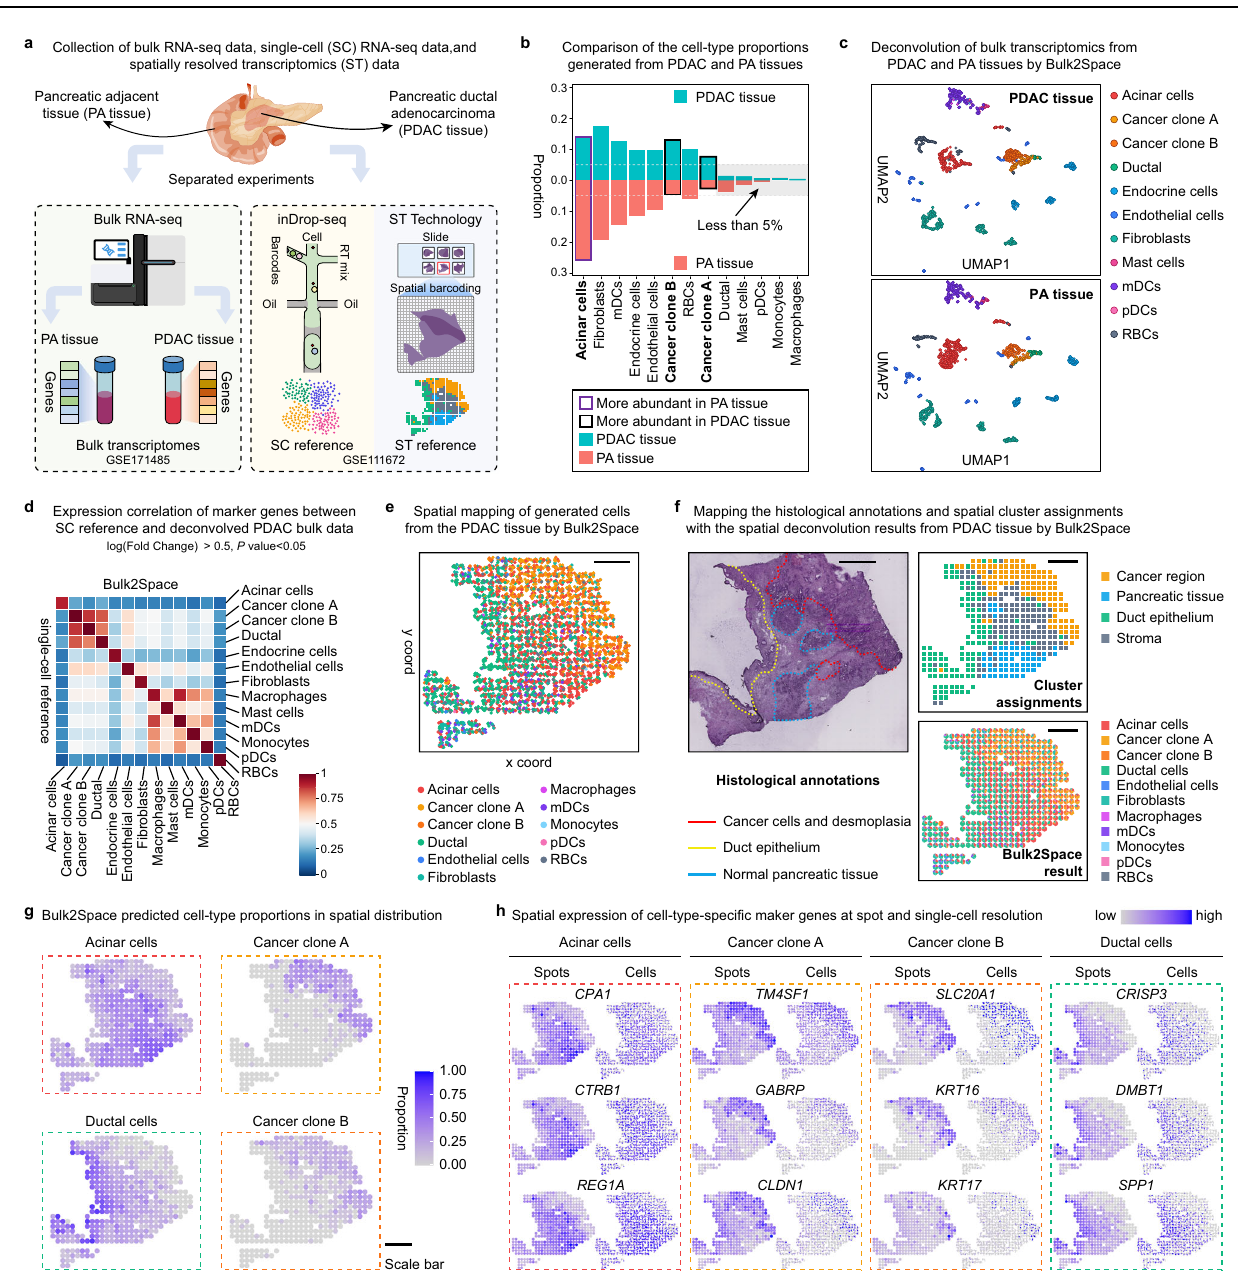
Fig. 3 | Spatially resolved analysis of PDAC by Bulk2Space. a Collection of pancreaticadjacent(PA)andPDACbulktranscriptomedata,PDACscRNA-seqdata, and PDAC spatial transcriptomics data. Two bulk data were sequenced by bulk RNA-seq. The scRNA-seq data sequenced by inDrop-seq 51 is used as the single-cell reference.OnesliceofthesectionedPDACtissuesequencedbyST 14 wasemployed as the spatial reference. b The cell-type proportions of single cells generated from PDACandPAtissuesbyBulk2Space.Purplebox,theproportionofthecelltypewas higher in PA tissue than that in PDAC tissue. Black box, the proportion of the cell typewashigherinPDACtissuethanthatinPAtissue.Teal,thePDACtissue.Red,PA tissue. c TheclusteringspaceofsinglecellsgeneratedfromthePDAC(Top)andPA (Bottom)bulkdatabyBulk2SpaceusingUMAPlayout.Differentcolorsrepresented distinct cell types. d Pairwise expression correlation of cell-type-speci fi c marker genes between single cells generated by Bulk2Space and the single-cell reference